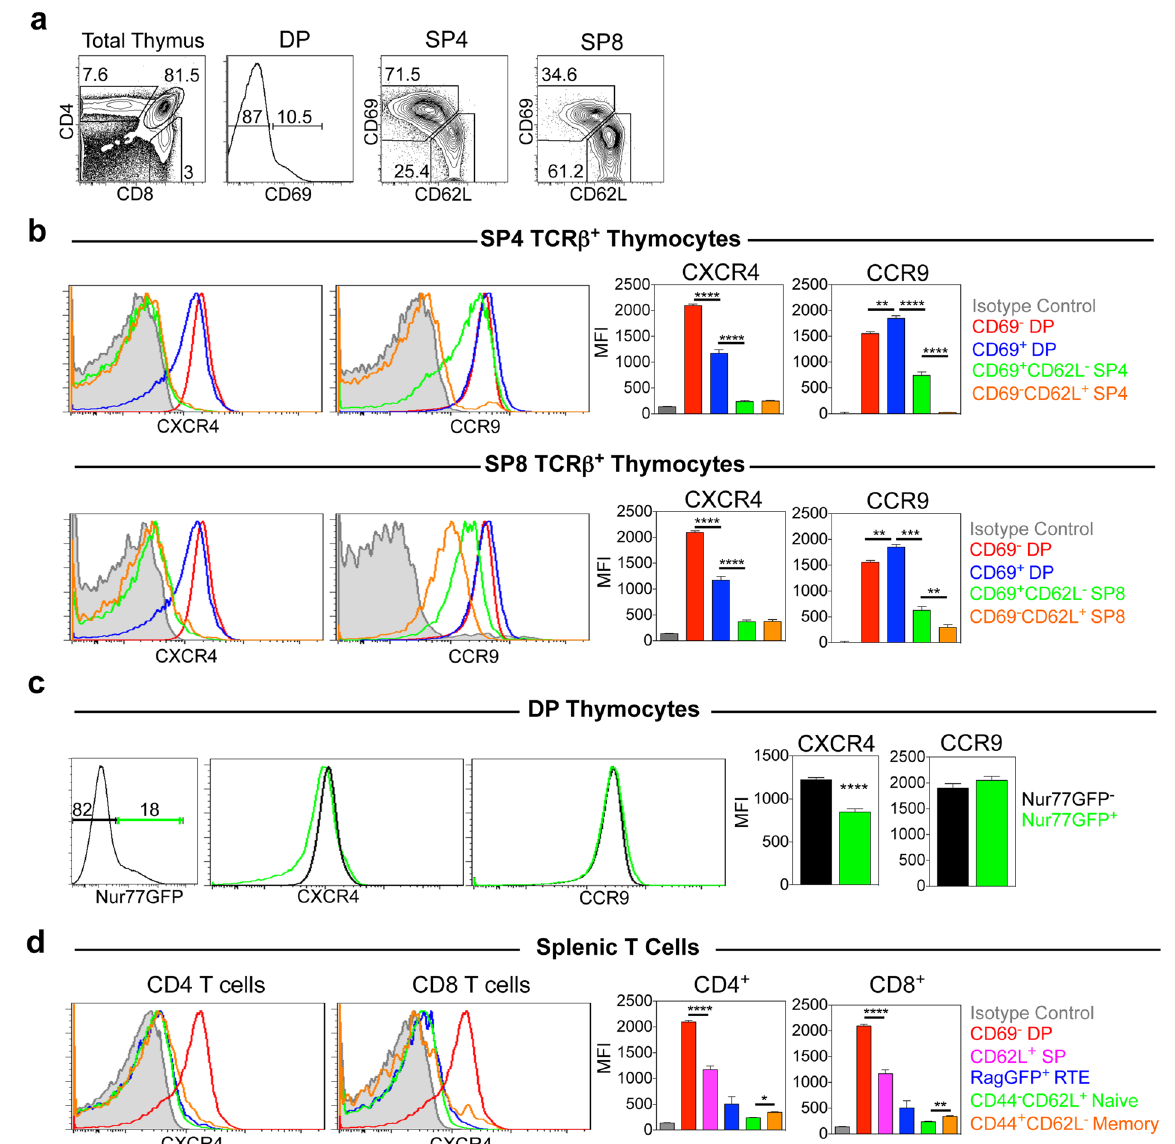
Figure 2. Positive Selection Initiation Involves Progressive CXCR4 Downregulation In DP Thymocytes. ( a ) Identification of CD69 − DP, CD69 + DP, CD69 + CD62L − , and CD69 − CD62L + SP4 and SP8 thymocytes. ( b ) Representative FACS analysis and MFI of CXCR4 and CCR9 expression in the indicated thymocyte subsets isolated from adult WT mice. ( c ) Representative FACS analysis and MFI of CXCR4 and CCR9 expression by Nur77GFP + and Nur77GFP − DP thymocytes from Nur77GFP mice. ( d ) Representative FACS analysis and MFI of CXCR4 expression by splenic T cell subsets in WT Rag2GFP mice, RTE (Recent Thymic Emigrants, Rag2GFP + ), Naïve T cells (CD62L + CD44 − ), Memory T cells (CD62L − CD44 + ). Grey histograms in b and d show isotype control staining for CXCR4 or CCR9, pre-gated on CD69 − DP thymocytes. Graphs in d show MFI of CXCR4 on CD62L + SP thymocytes and CD69 − DP thymocytes for comparison. MFI analysis is calculated from one experiment, representative of at least 3 independent experiments. n > 10, unpaired Student’s t test * p < 0.05, ** p < 0.01 *** p < 0.001, **** p < 0.0001. Error bars represent